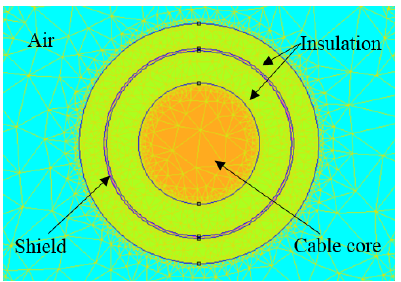
Figure 1. FEMM model of a single 50 mm 2 copper HV traction